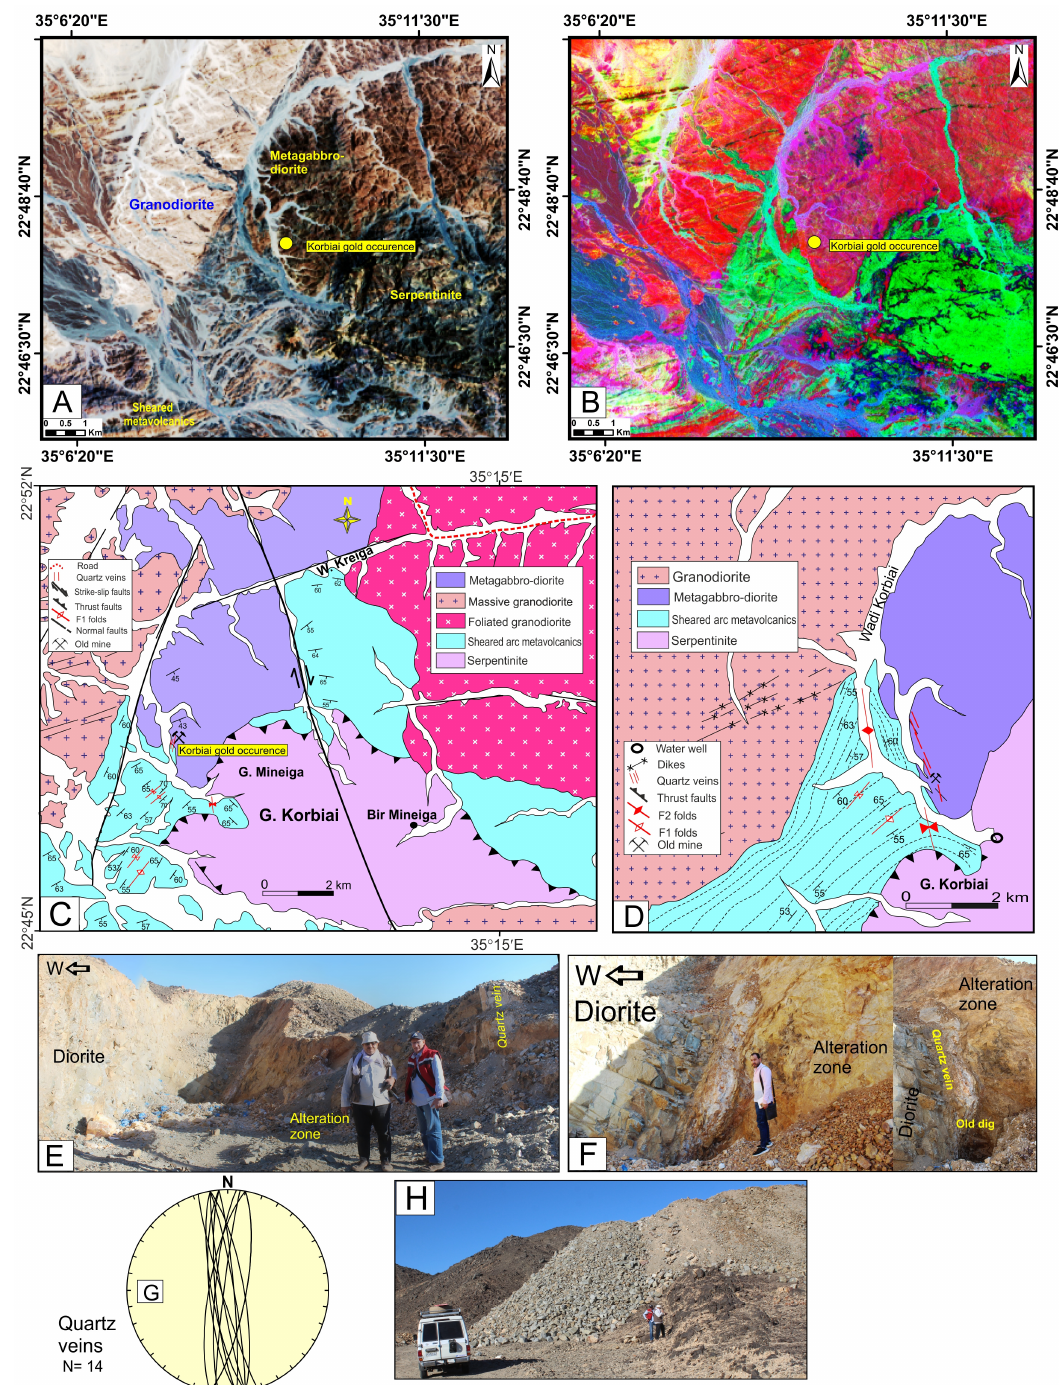
Figure 16. ( A , B ) Location of Korbiai gold occurrence on Landsat-8 OLI band composites RGB-753 and Landsat-8 OLI band ratio RGB-7/6 ( C ) Geological map of the area around the Korbiai gold occurrence (modified after EMRA, 2012), ( D ) Detailed geological map of the Korbiai gold occurrence (modified after EMRA, 2012), ( E ) The alteration zone in the Korbiai gold mine along the contact with diorite. The alteration zone is characterized by the presence of recrystallized quartz pods, fracture-filling ankerite, sulfidized granitic offshoots, boudinage of the granodiorite bodies, and intermingling carbonate sericite veinlets, ( F ) Old digging along W-dipping quartz vein marking the contact between diorite and the alteration zone of the Korbiai gold mine, ( G ) The black lines are the great circle plots of the quartz veins in the Korbiai gold occurrence ( H ) Recent excavation and rock smashing at Korbiai gold